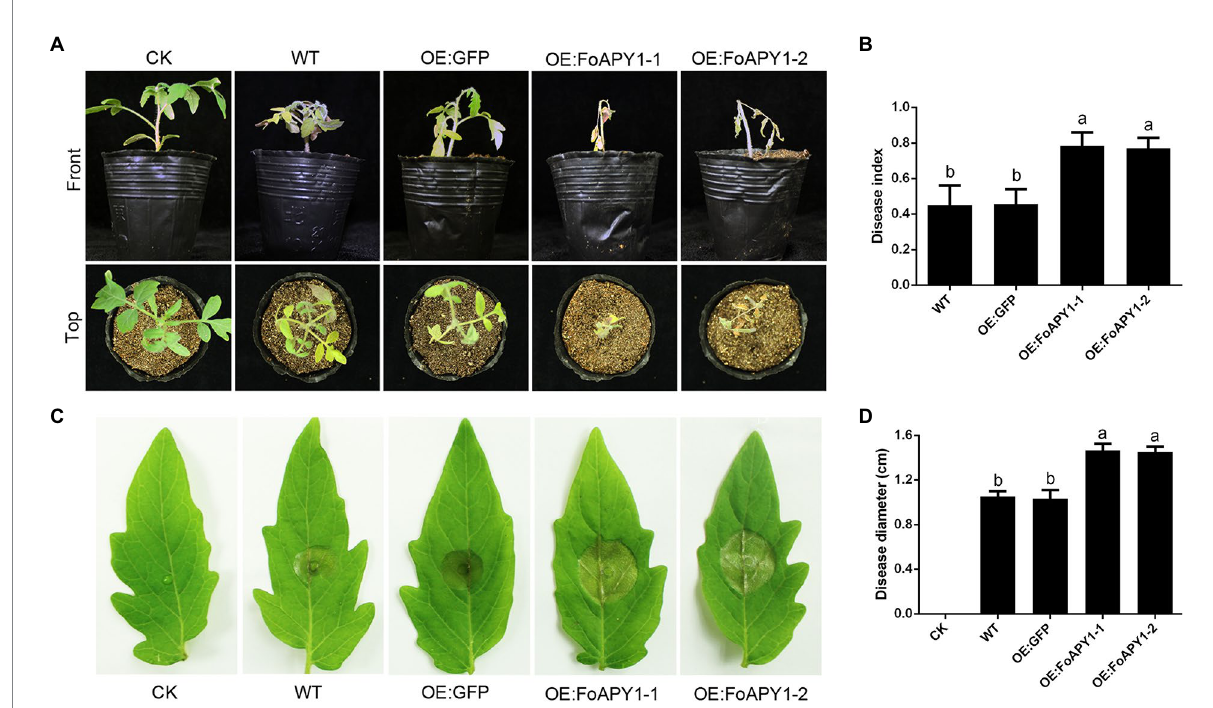
FIGURE 7 FoAPY1 promotes the infection of fungal pathogens in tomato plants. (A) Phenotypes of WT, OE:GFP and OE:FoAPY1tomato seedlings inoculated with conidia of F. oxysporum at 5 × 10 6 conidia/mL. The images were taken at 16 days post-inoculation. CK represents the tomato seedlings treated with water. (B) The record of disease index of all the tomato seedlings to represent the disease severity. The disease severity was defined from 1 to 5 according to the disease degree, and 0 represents no disease symptoms. (C) The disease phenotypes of tomato leaves inoculated with conidia of B. cinerea . Five microlitres of conidial suspension at 5.0 × 10 5 conidia/mL was dropped onto the surface of all tomato leaves and incubated at 22 ° C for 60 h. The disease lesions on different types of tomato leaves were recorded, and the negative control was performed on WT leaves with infection buffer (6.7 mm K 2 HPO 4 and 10 mM glucose). (D) Quantification of lesion diameter on tomato leaves inoculated with B. cinerea . Three repeated experiments were performed, and ten leaves of different types of tomato were used in each experiment. All the data were calculated by one-way ANOVA for statistical tests. The same letters marked on the bars mean no significant differences, and the different letters indicate significant differences in values at p < 0.05 in the